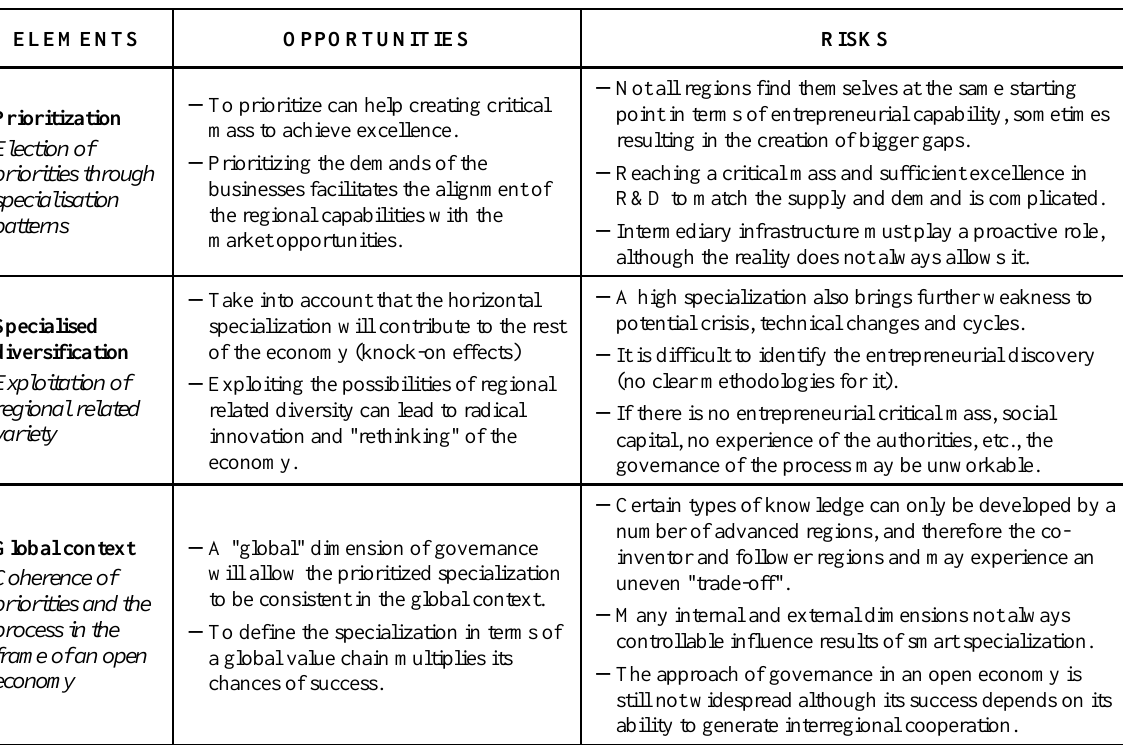
Table 2: Opportunities and Risks Regarding Main Elements of Smart